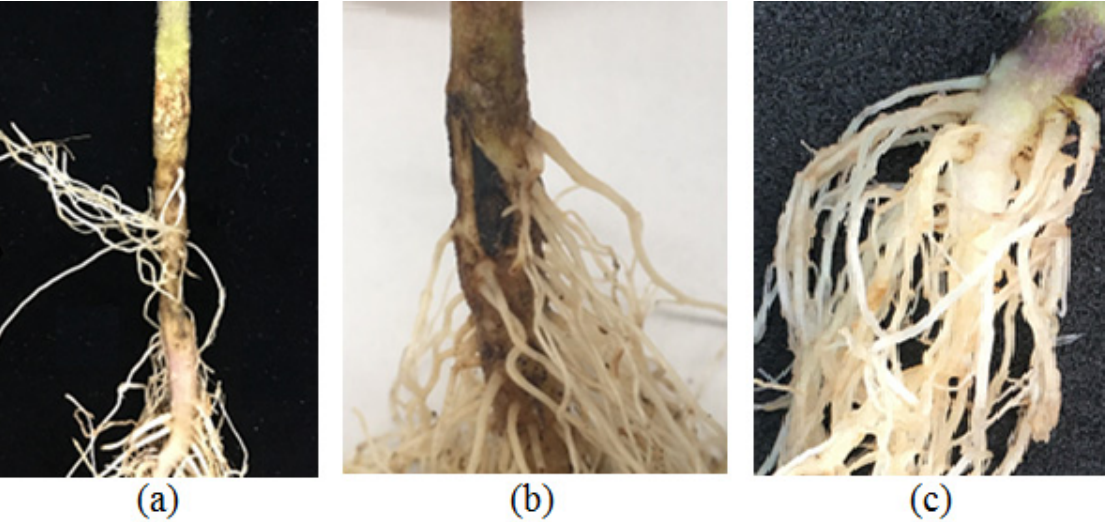
Figure 6. The symptoms caused by Rhizoctonia solani AG4 on tomato cv. Superchief crown. ( a , b ) show crown rot and canker, respectively; ( c ) represents control; uninoculated plant with the pathogen. Table 3. Effect of four actinomycetes isolates on tomato seedlings cv. Superchief growth parameters and disease severity. Growth parameters and disease severity were measured simultaneously when seedlings were uprooted and washed; their dry weights were measured after 48h incubation at 60 °C. Treatment